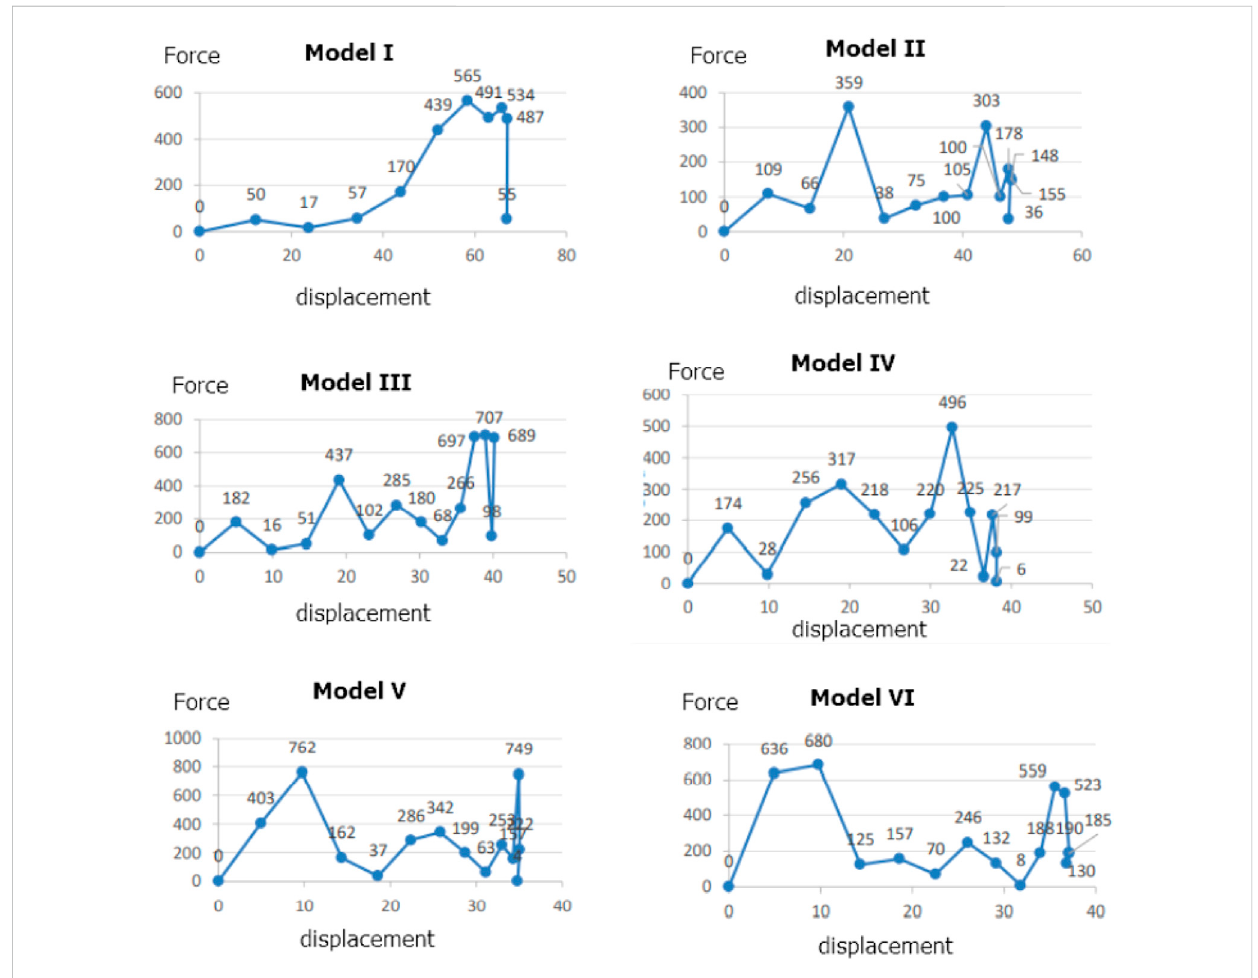
FIGURE 15 Force — displacement diagram of different structures under dynamic